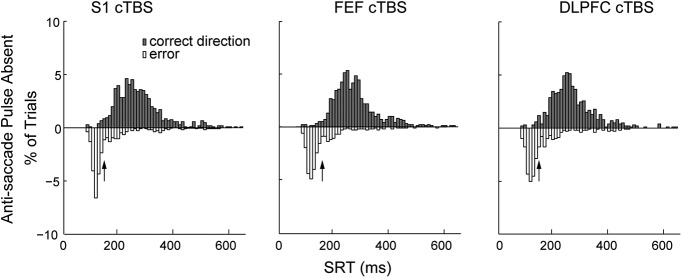
Derivation of the early and late PPC pulse bins based on anti-saccade reaction times. Reaction time distributions were calculated for correct and direction error anti-saccades in PPC pulse absent trials on each cTBS session. A binomial sign test was performed that compared the distributions, and arrows indicate the first reaction time bin where the two distributions were no longer significantly different. This value was taken as the boundary for early and late PPC pulses.